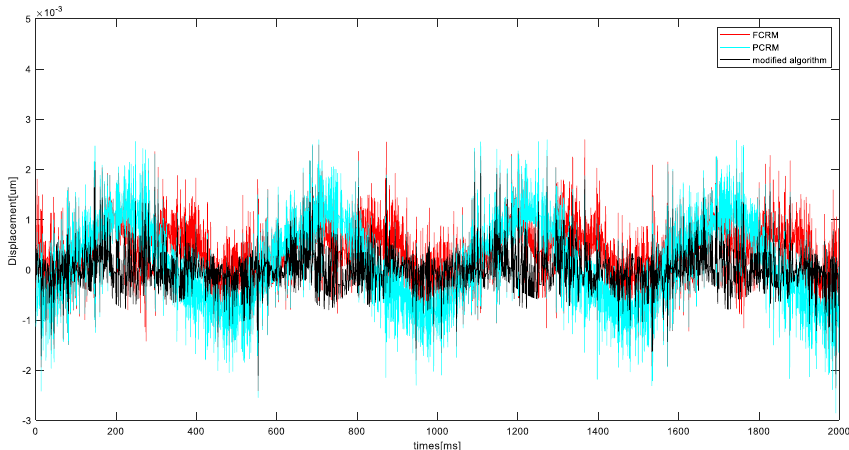
Figure 10. Error comparison of the modified model, FCRM, and PCRM when the fre- quency is 5 Hz.